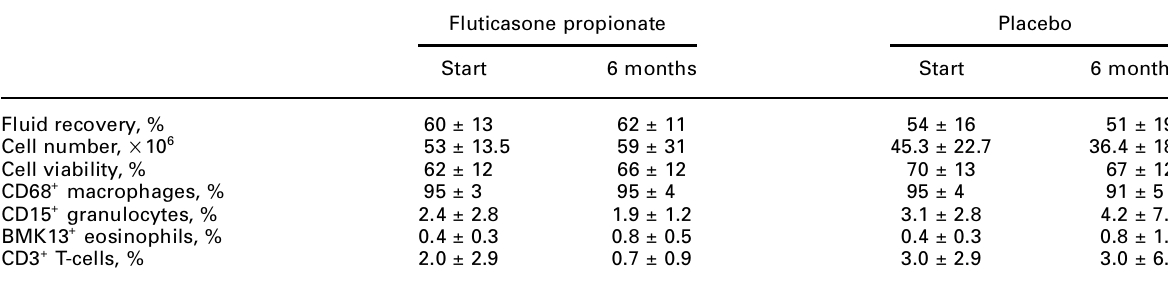
Table 2. Characteristics of bronchoalveolar lavage (mean ±SD)